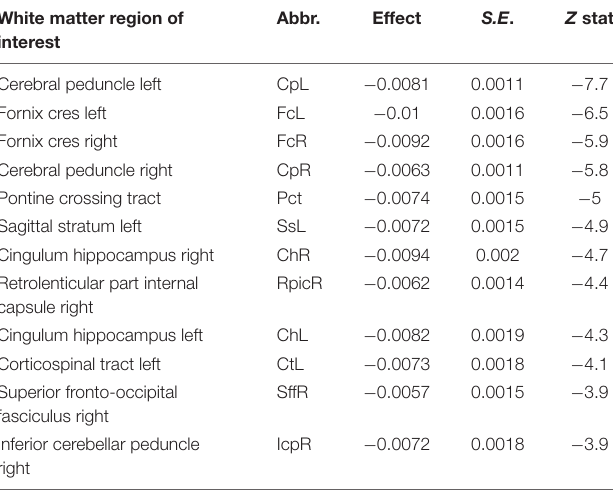
TABLE 3 | Summary of effects of body mass index on FA